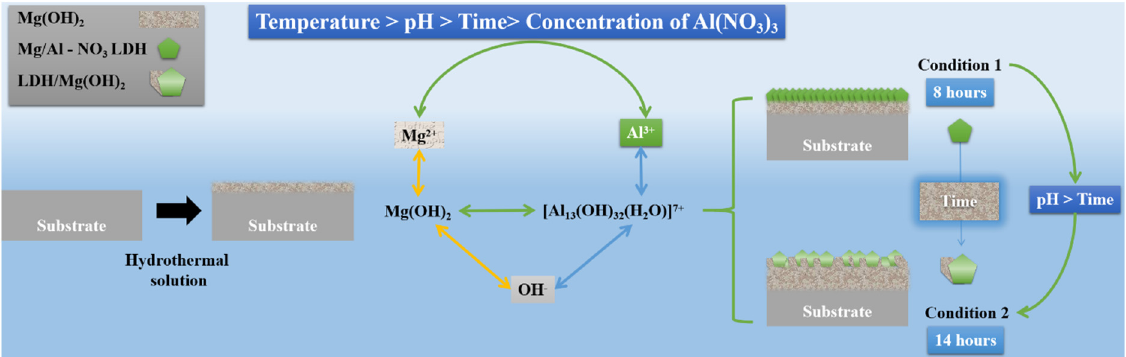
Figure 8. Growth mechanism of the Mg-Al LDH coatings in conditions 1 and 2.